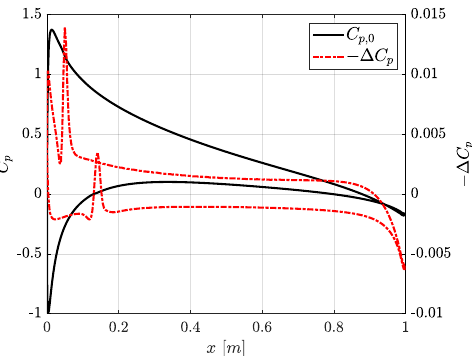
Figure 4. Mean velocity profiles ( top ) and skin-friction coefficient ( bottom ) for the NACA0012 airfoil, at an incidence of α = 0 ◦ ( left ) and α = 4 ◦ ( right ). The top row shows the mean profile over the suction side in law-of-the-wall form at x / c = 0.5, and compares with data from ref. [34]. The bottom row plots the evolution of the friction coefficient along the chord, and compares with data from ref. [32], represented with symbols.